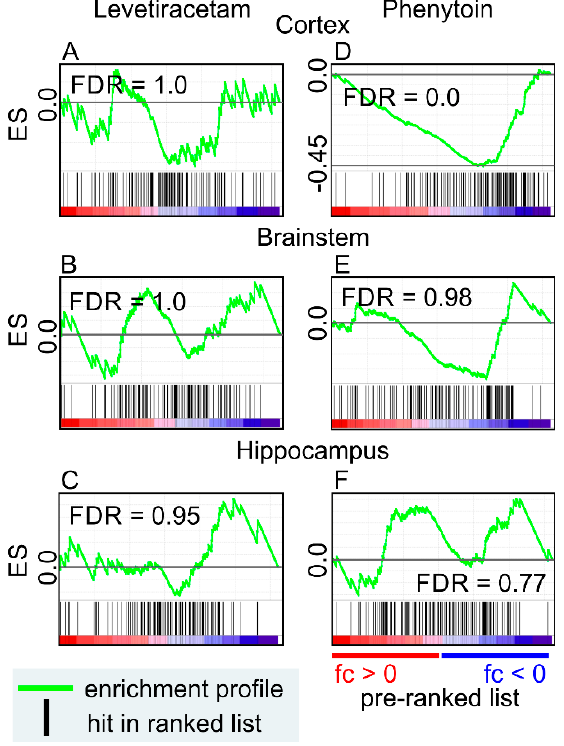
Figure 4. The effect of two antiepileptic drugs on EV-related genes in the cortex, brainstem, and hippocampus. Microarray gene expression data obtained from the rat brain tissue after a 90-d treatment with levetiracetam or phenytoin was used to construct a rank list for the Gene Set Enrichment Analysis. The top100 EV-related proteins from Vesiclepedia (http://microvesicles.org/, accessed on: 1 December 2018) were used as a gene set. ( A – C ) Levetiracetam treatment did not induce any enrichment of the EV-related genes in any of the brain areas. ( D ) Phenytoin treatment induced a negative enrichment of EV-related genes in the cortex. The effect was brain-region specific as no enrichment was observed in the brainstem or hippocampus ( E , F ). Abbreviations: ES, enrichment score; FDR, false discovery rate; fc, fold change.